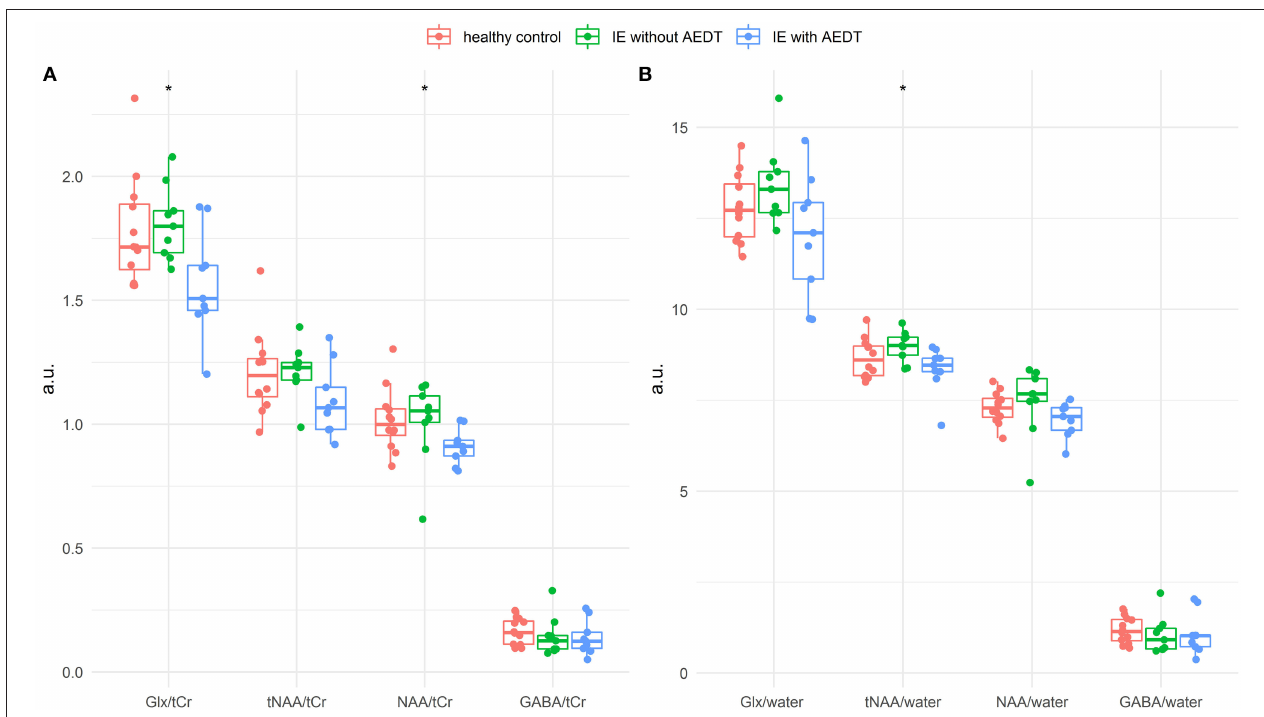
FIGURE 3 | Box plot of thalamic metabolite concentrations relative to creatine (A) and water (B) in healthy control dogs (red), dogs affected by idiopathic epilepsy with antiepileptic drug treatment (IE with AEDT in blue), and non-treated epileptic dogs (IE without AEDT in green). The Kruskal–Wallis test revealed statistically significant difference in the metabolites NAA/creatine and Glx/creatine, as well as tNAA/water (asterisk). Glx, glutamate–glutamine complex; tCr, total creatine; tNAA, total NAA; NAA, N-acetyl aspartate; GABA,